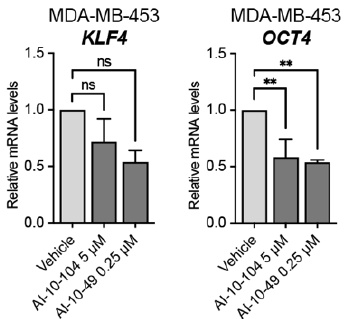
gene markers. RUNX1 commercial inhibitors AI-10-104 and -49 both downregulated KLF4 and OCT4 gene expression in MDA-MB-453 cells cultured in forced suspension (Figure 3).